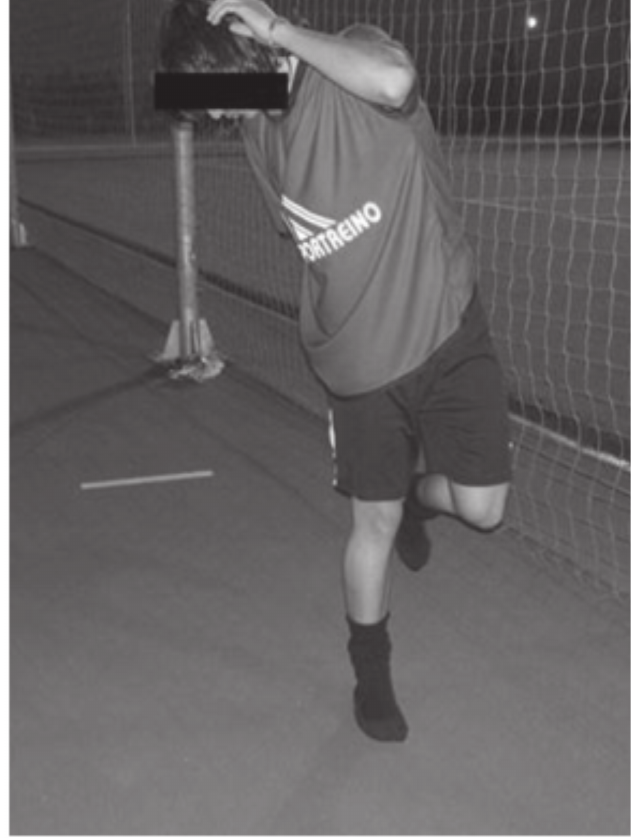
Figura 1 - Single-leg hop